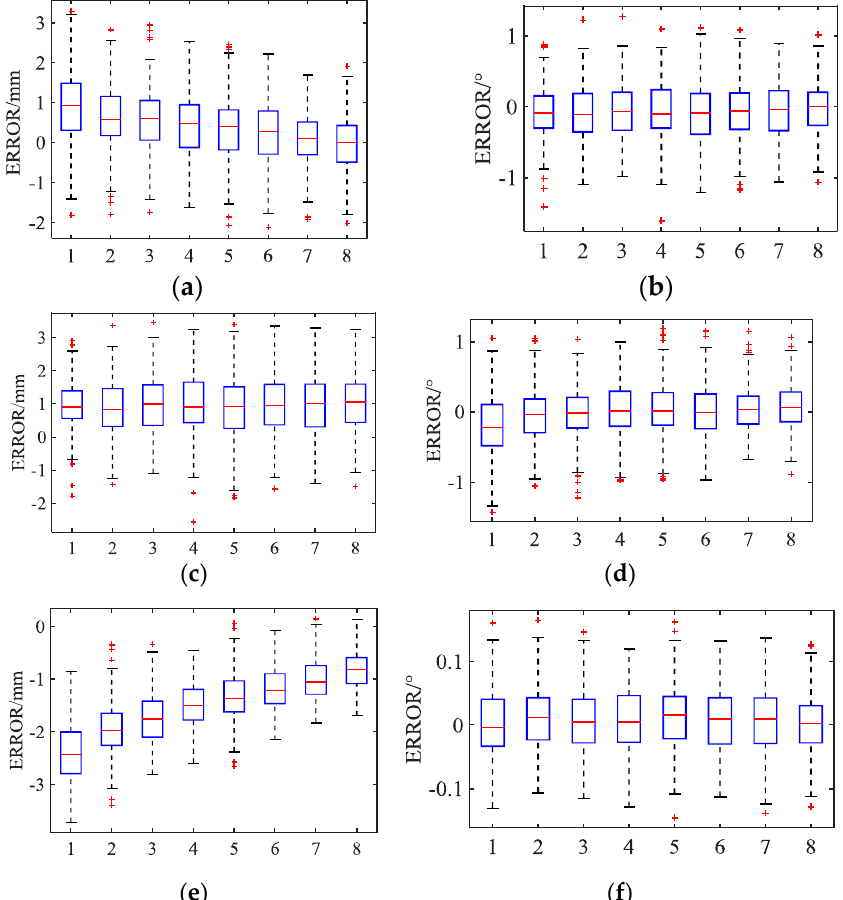
Figure 11. Measurement errors of the monocular vision system. ( a ) E X (Groups 1–8). ( b ) E Rx (Groups 1–8). ( c ) E Y (Groups 1–8). ( d ) E RY (Groups 1–8). ( e ) E Z (Groups 1–8). ( f ) E RZ (Groups